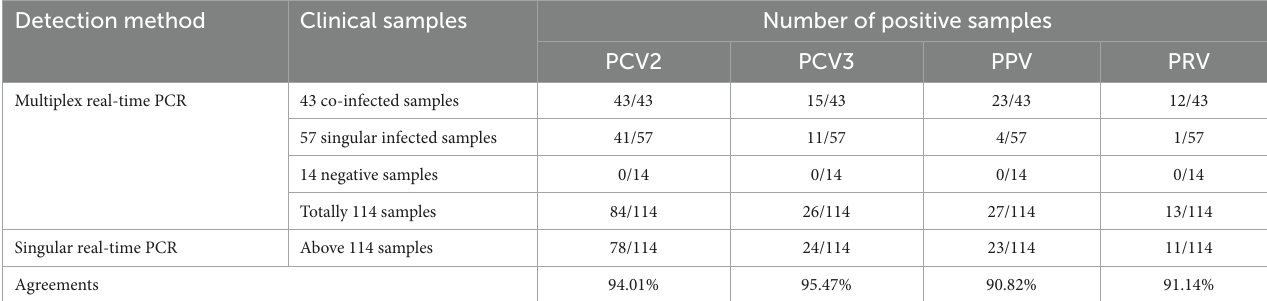
TABLE 4 Comparative results of clinical samples tested with both multiplex real-time PCR and singular real-time PCR. Detection method Clinical